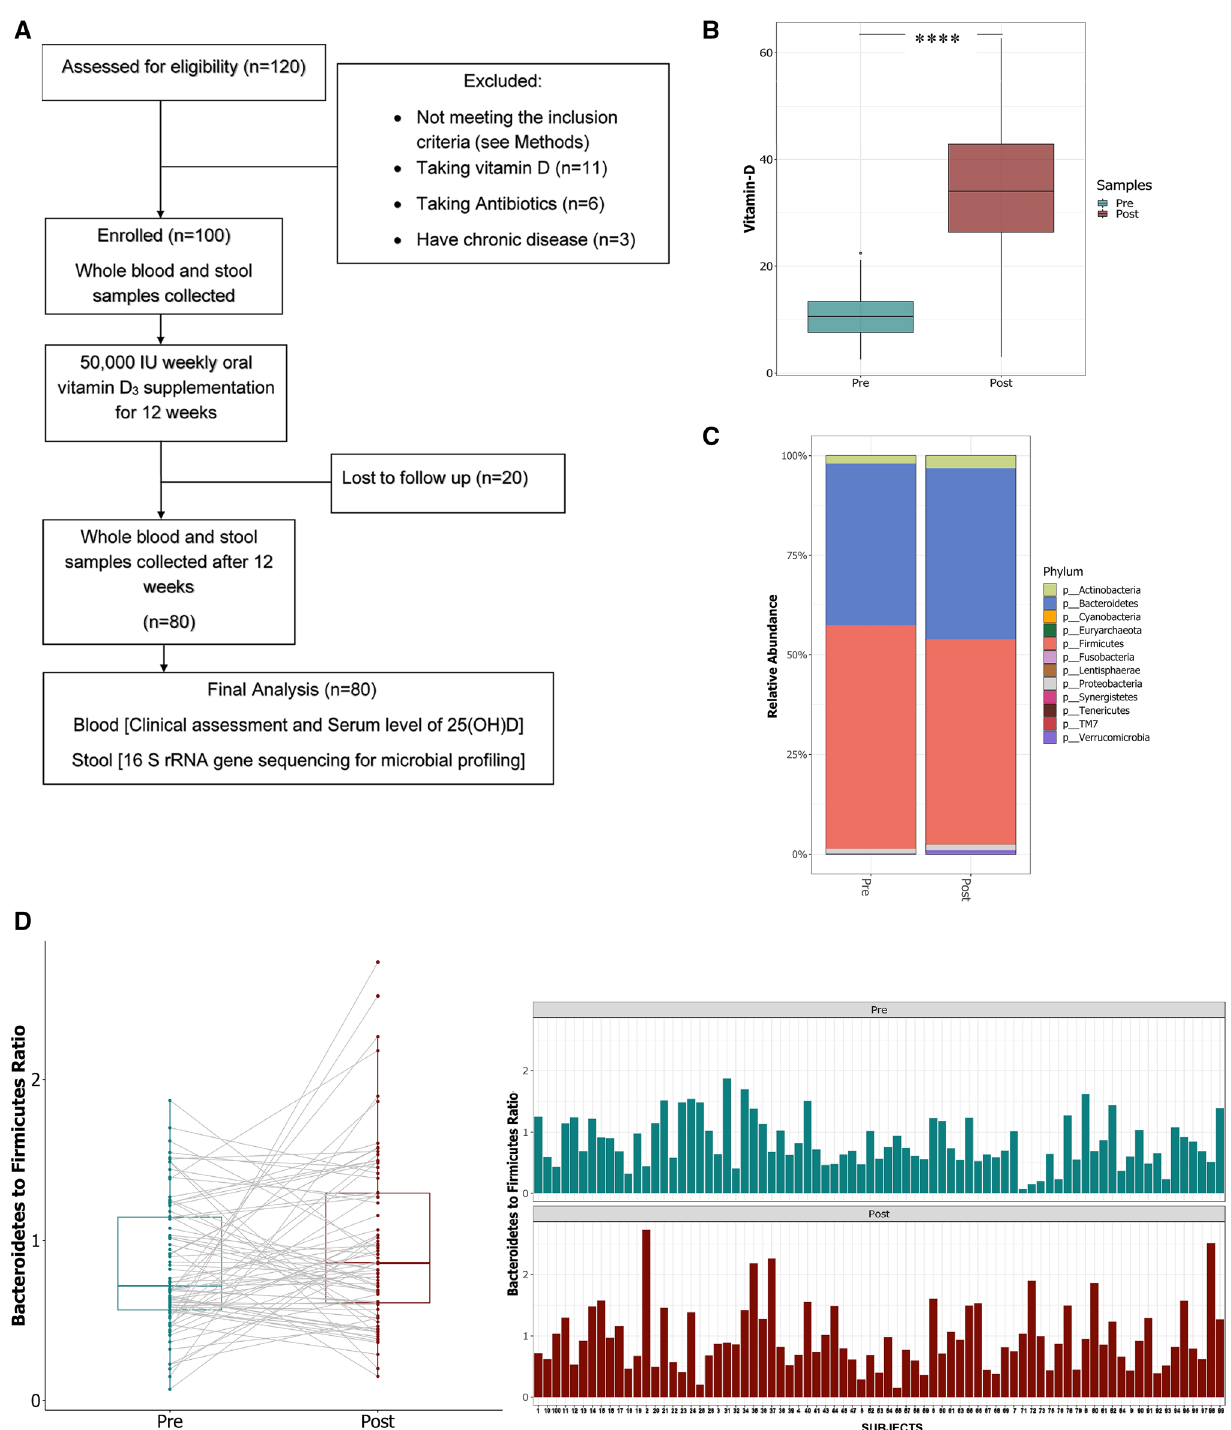
Figure 1. The schematic representation of study design and analysis. ( A ) Flow chart of subject selection along with inclusion/exclusion criteria. ( B ) Changes in serum levels of vitamin D(ng/ml) in study subjects pre- and post- supplementation. Microbiota composition in stool samples pre- and post- vitamin D supplementation. ( C ) The relative abundance of bacterial phyla: Firmicutes and Bacteroidetes were significantly impacted post Vitamin D (Wilcoxon test with false discovery rate (FDR)-Bonferroni corrected **** P < 0.0001 and * P < 0.05 respectively) ( D ) Comparison of the ratio of Bacteroidetes to Firmicutes pre- and post- vitamin D supplementation (Lmer4 borderline significant p = 0.0579) cumulative and per subject level. The figure was generated using (RStudio v 1.2 with R v 3.6) 87